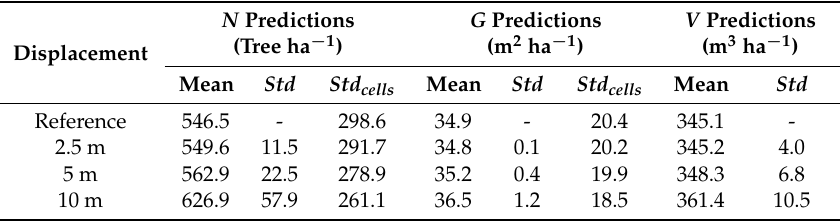
Table 3. Effect of plot positioning errors on the prediction of growing stock attributes. Mean values and standard deviations ( Std ) among replications were calculated using the 60 datasets containing positioning errors. For the case of stand density ( N ) and stand basal area ( G ), the standard deviation between cells was also computed ( Std cells